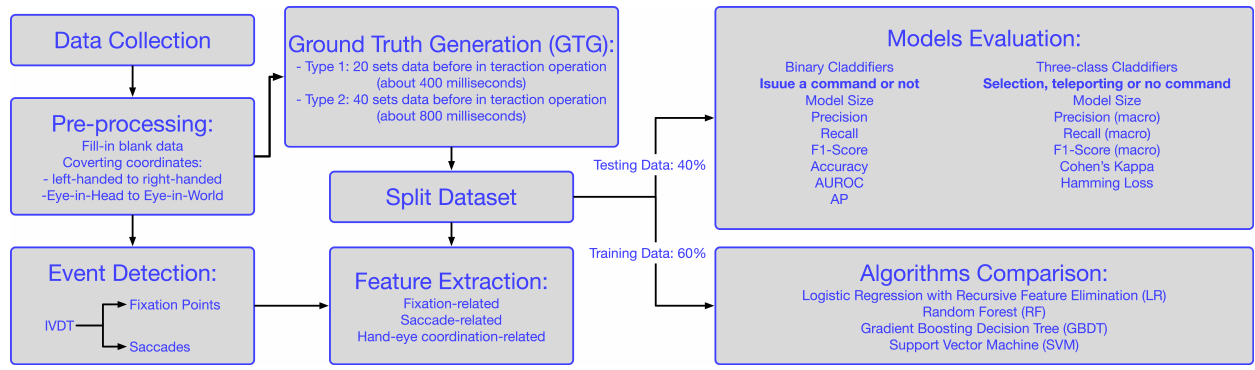
Figure 4. The pipeline to detect eye events, extract features, and train and evaluate